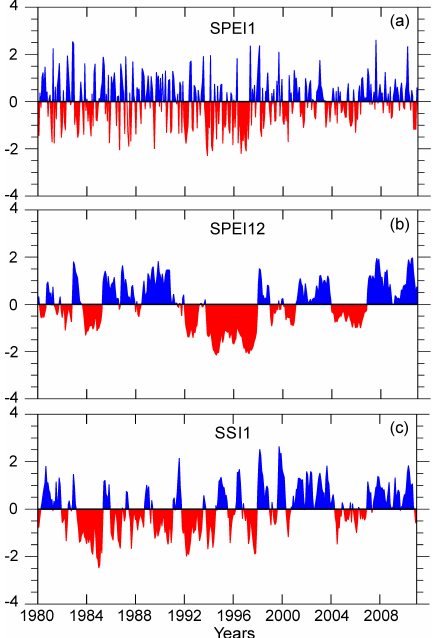
Figure 11. Time evolution of the SPEI in the Congo River basin after 1 (a) and 12 months (b) and the Standardised Streamflow In- dex (SSI) (c) that was computed for the Congo River’s discharge. Period: